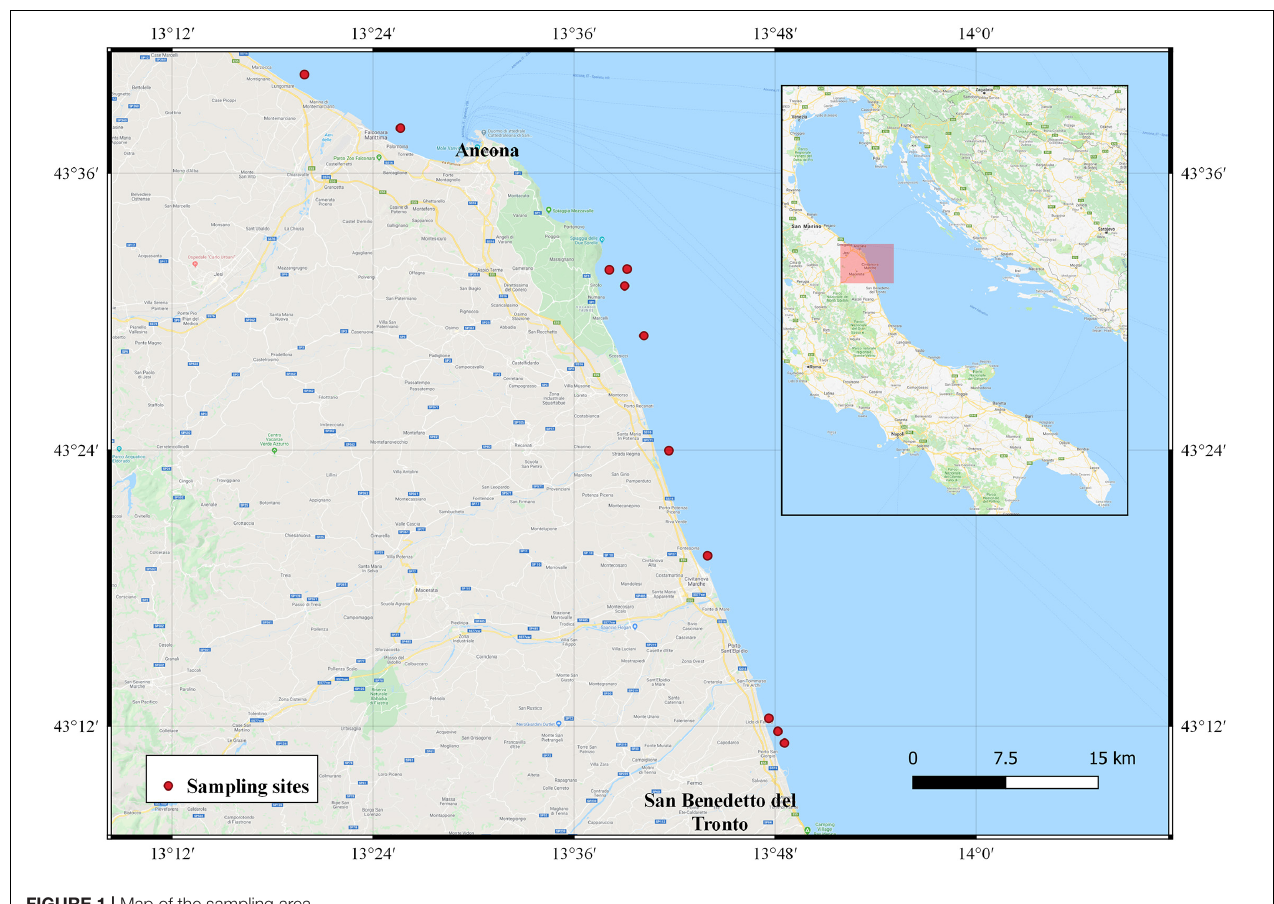
FIGURE 1 | Map of the sampling